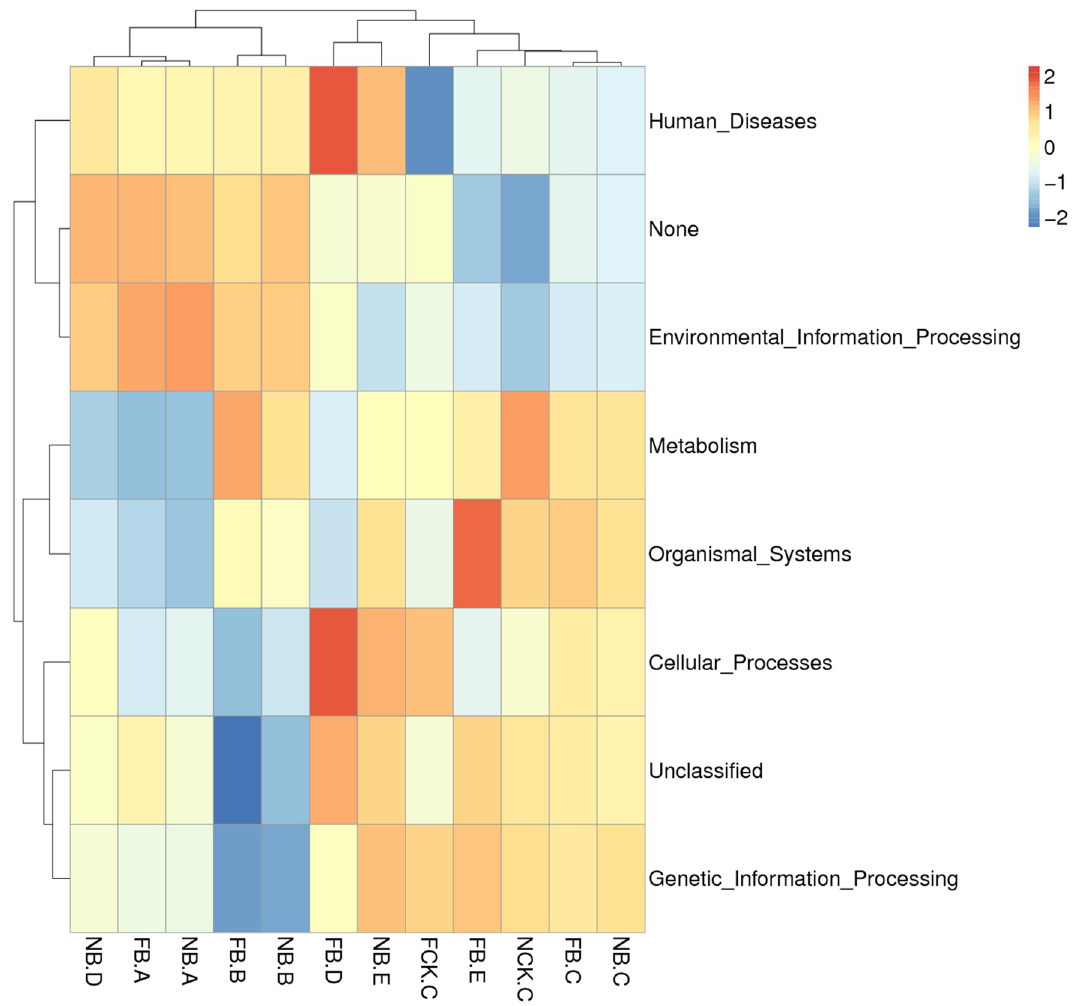
Figure 6. PICRUSt analysis of the bacterial microbiome in each plant compartment. The top 35 the bacterial microbiome and their abundance information in each sample were mapped and clustered from the functional difference